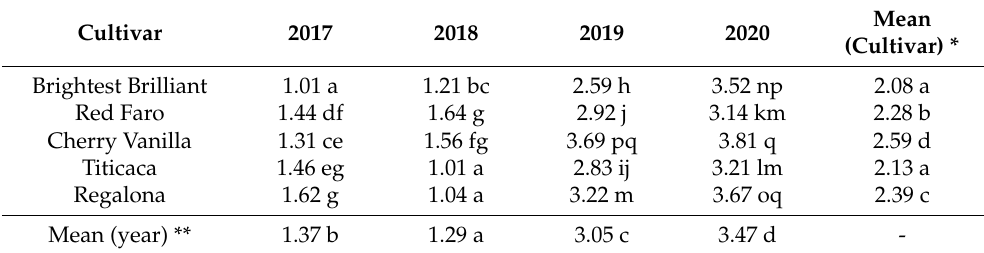
Table 4. Productivity of quinoa grain, t/ha.